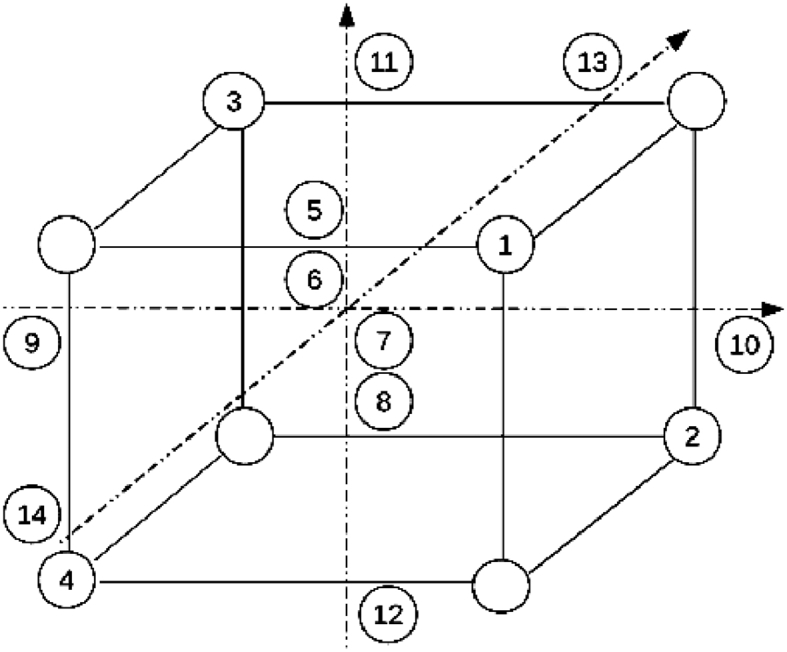
Small central composite design.